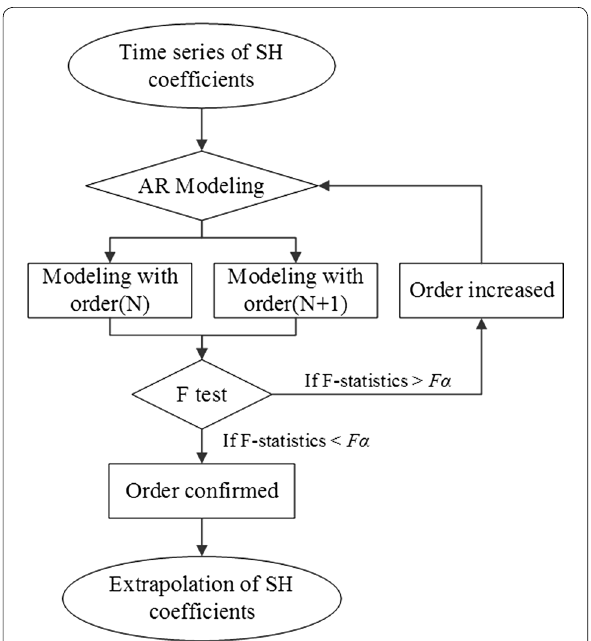
Fig. 1 Flowchart of AARM for extrapolation of SH